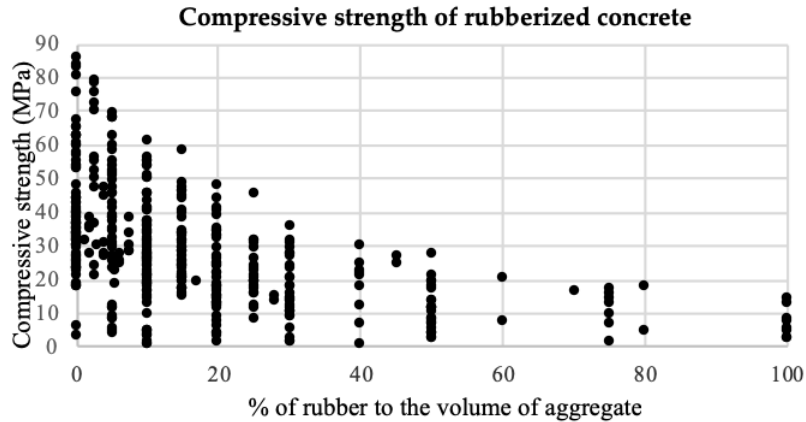
Figure 1. Compressive strength of 457 experiments of rubberized concrete.